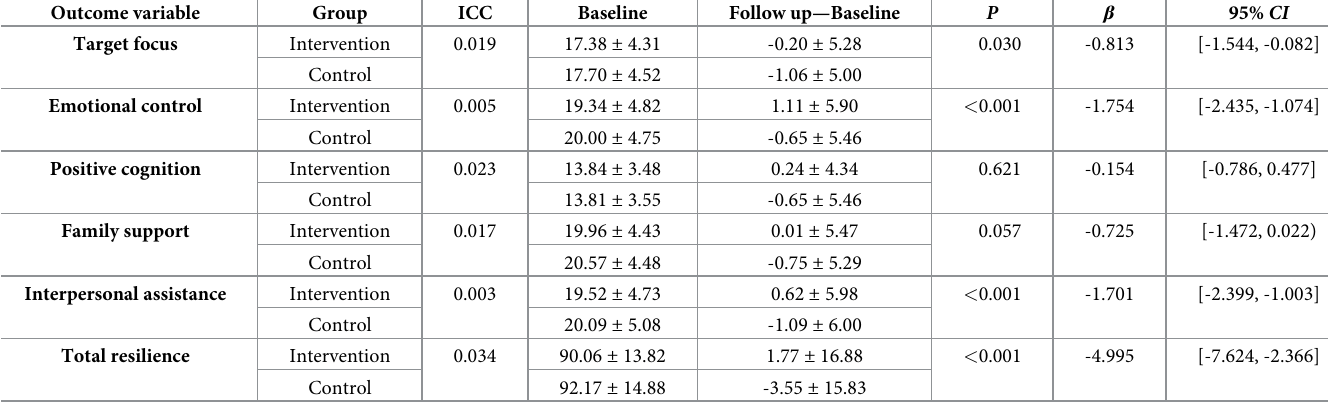
Table 3. Comparison of changes in psychological resilience scores between the two groups during follow-up after PSM (n = 1, 338). Outcome variable